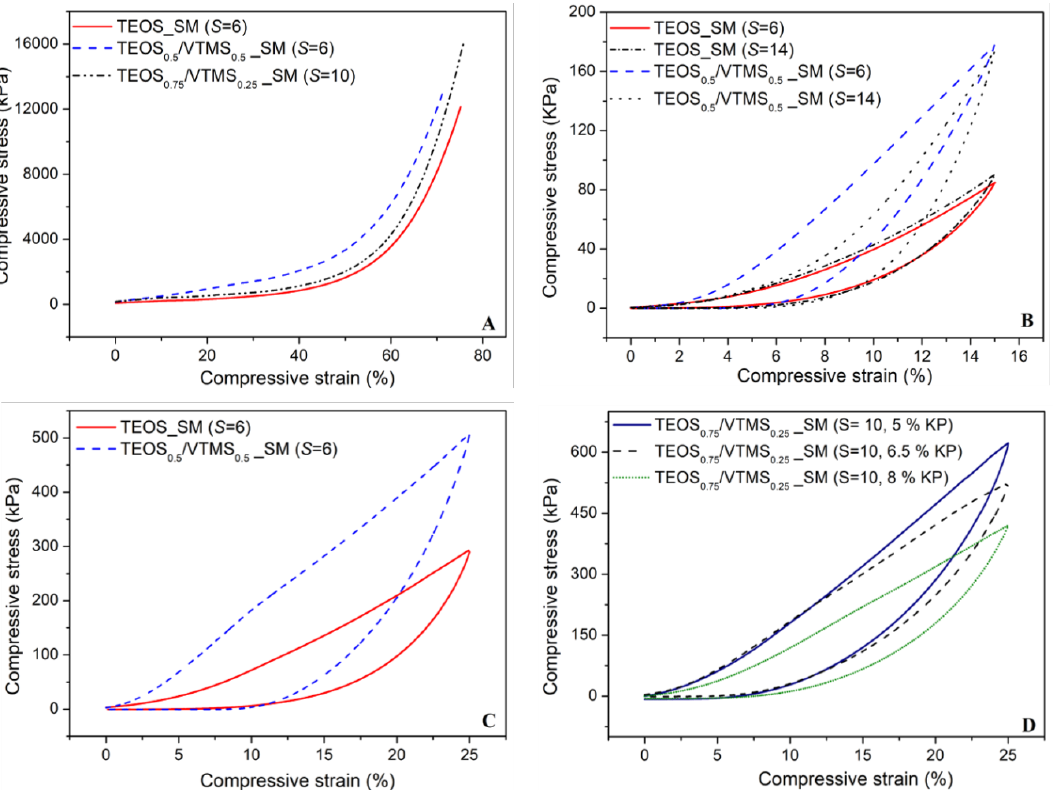
Figure 7. Stress–strain curves obtained by uniaxial compression with a load cell of 3 kN ( A , C , D ) and 50 N cell ( B ). ( A ) Silica aerogel composites (TEOS; TEOS 0.5 /VTMS 0.5 and TEOS 0.75 /VTMS 0.25 ; S = 6, 6 and 10) tested up to maximum densification. Effects of ( B ) S in TEOS and TEOS/VTMS-derived systems, ( C ) co-precursor and ( D ) different fibers content, under a uniaxial compression-decompression cycle.